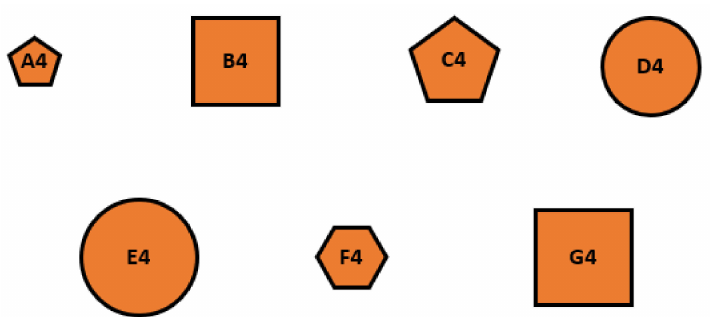
Figure 5. The third set of graphics.